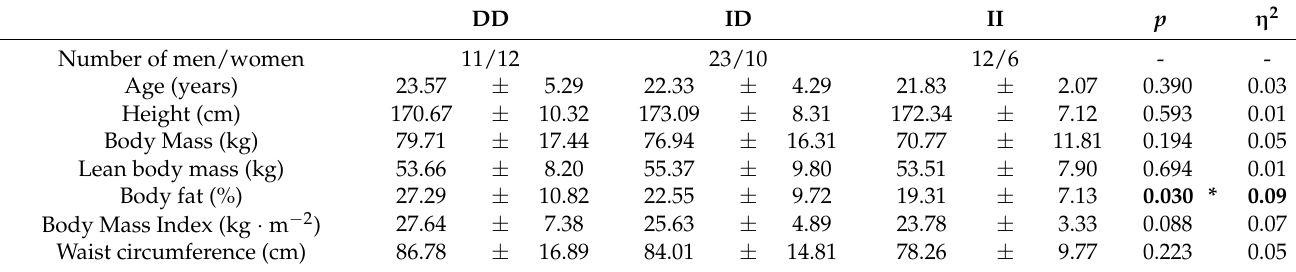
Table 2. Differences in the analyzed outcomes between the three ACE gene I/D polymorphism